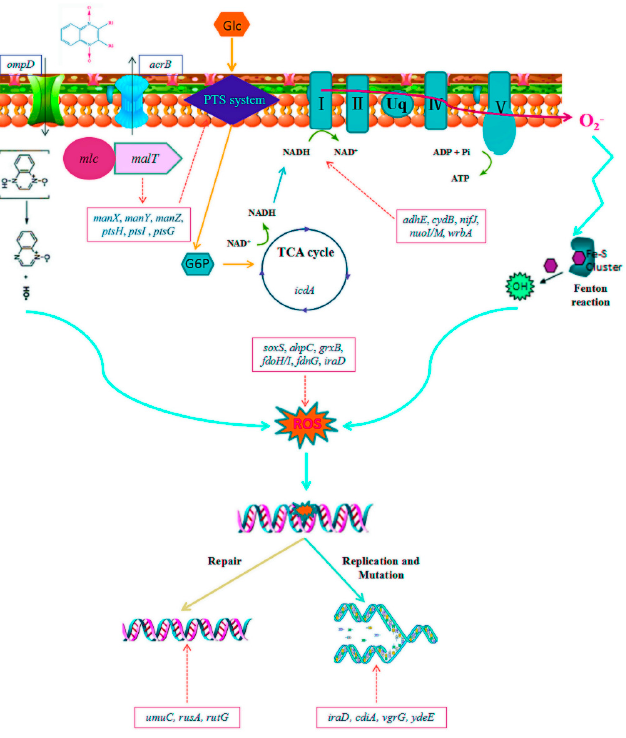
Figure 5. The hyperthetical resistance mechanism involved in the development of QdNOs resistance. The decrease in the expression of the outer membrane porin gene ompD leads to the loss of OmpD protein, which reduces the intake of olaquindox. The up-regulation of multidrug resistance efflux pump gene acrB increases olaquindox efflux. The PTS systerm initiate a metabolic feedback dependent on tricarboxylic acid (TCA) cycle, stimulate the oxidation of NADH through the electron transport chain, promote superoxide formation, damage the structure of Fe-S clusters, lead to the formation of hydroxyl radicals and finally damage DNA; The Changes in the expression of genes umuC, rusA, and rutG trigger DNA repair; Changes in the expression of genes such as iraD, cdtA, vgrG, and ydeE cause gene mutations and affect DNA replication.